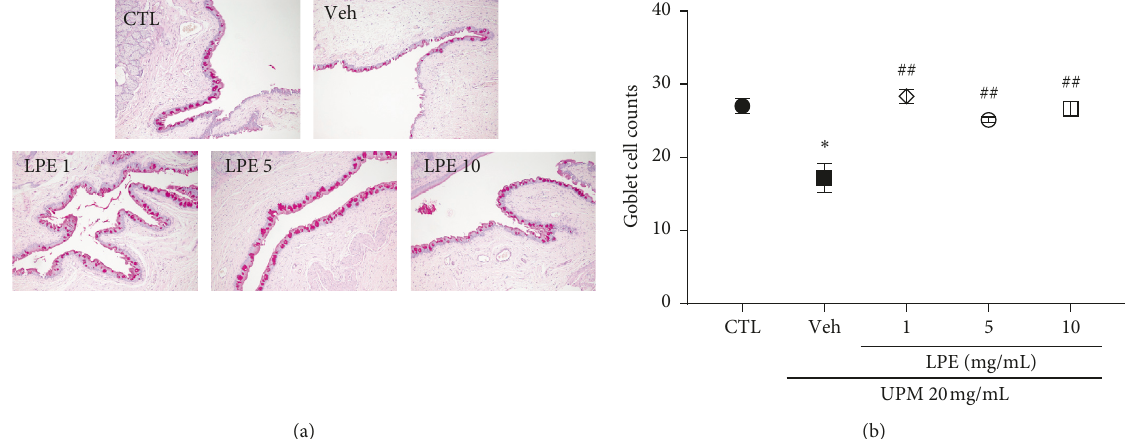
Figure 6: Effect of Liriope platyphylla extract (LPE) on conjunctival goblet cells in urban particulate matter (UPM)-induced dry eye syndrome (DES). (a) Representative images of goblet cells stained with periodic acid-Schiff (PAS). (b) Graph of goblet cell counts. Data shown are mean ± standard error. ∗ p < 0 . 05 vs. Control (CTL); ## p < 0 . 01 vs. Vehicle